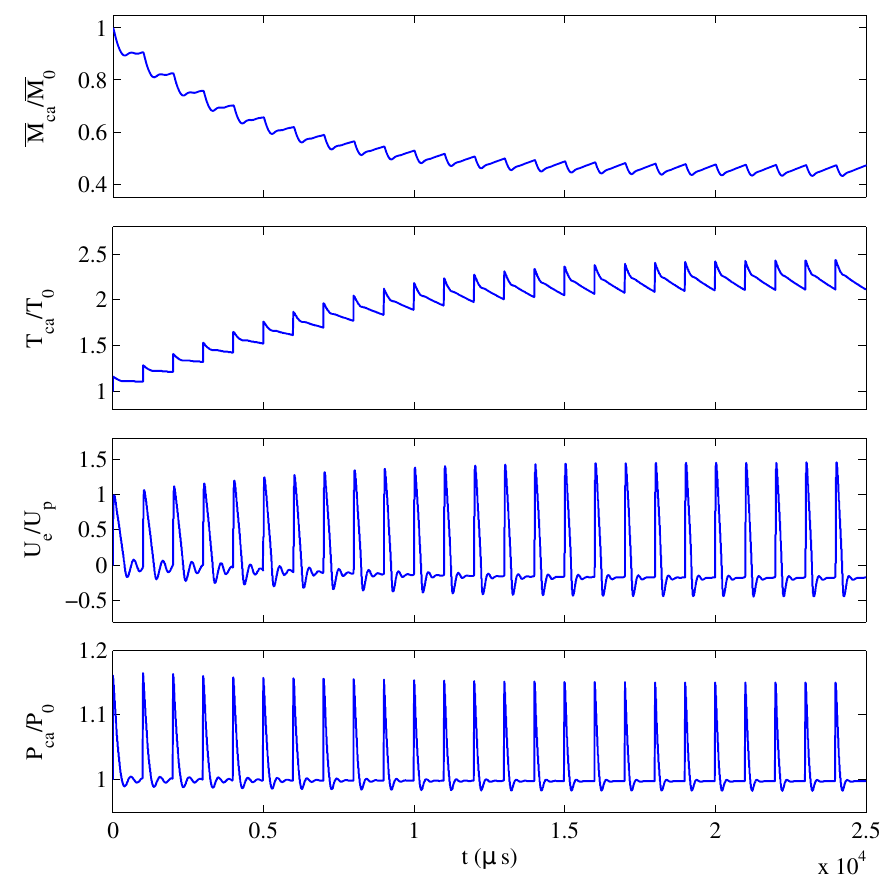
Figure 12. Evolution of the main thermo-fluid-dynamic parameters of the actuator over the first 25